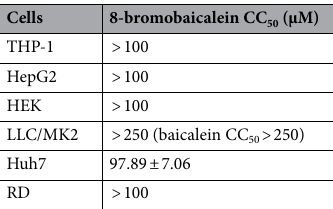
Table 1. Cytotoxicity of 8-bromobaicalein to cell lines. An error was calculated from three independent experiments.